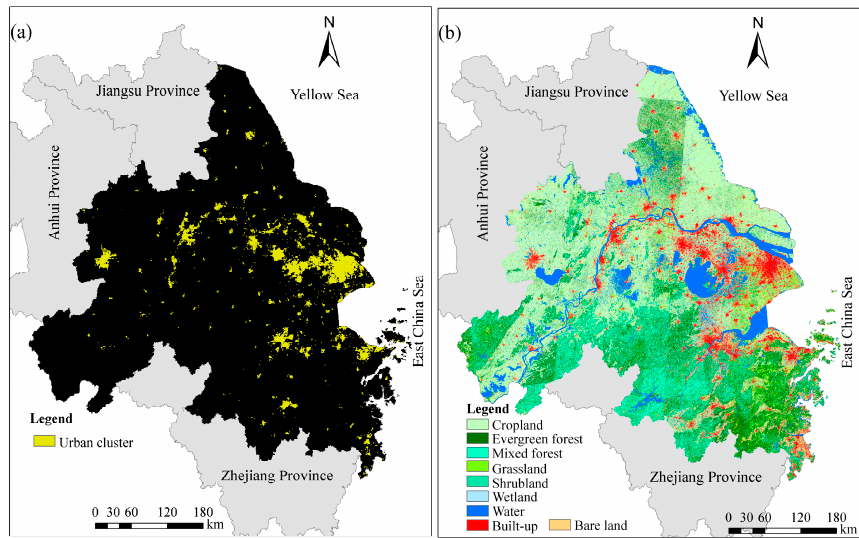
Figure 2. Urban clusters derived from SNPP / VIIRS nighttime light data ( a ) and land cover data ( b ) in the year 2015.